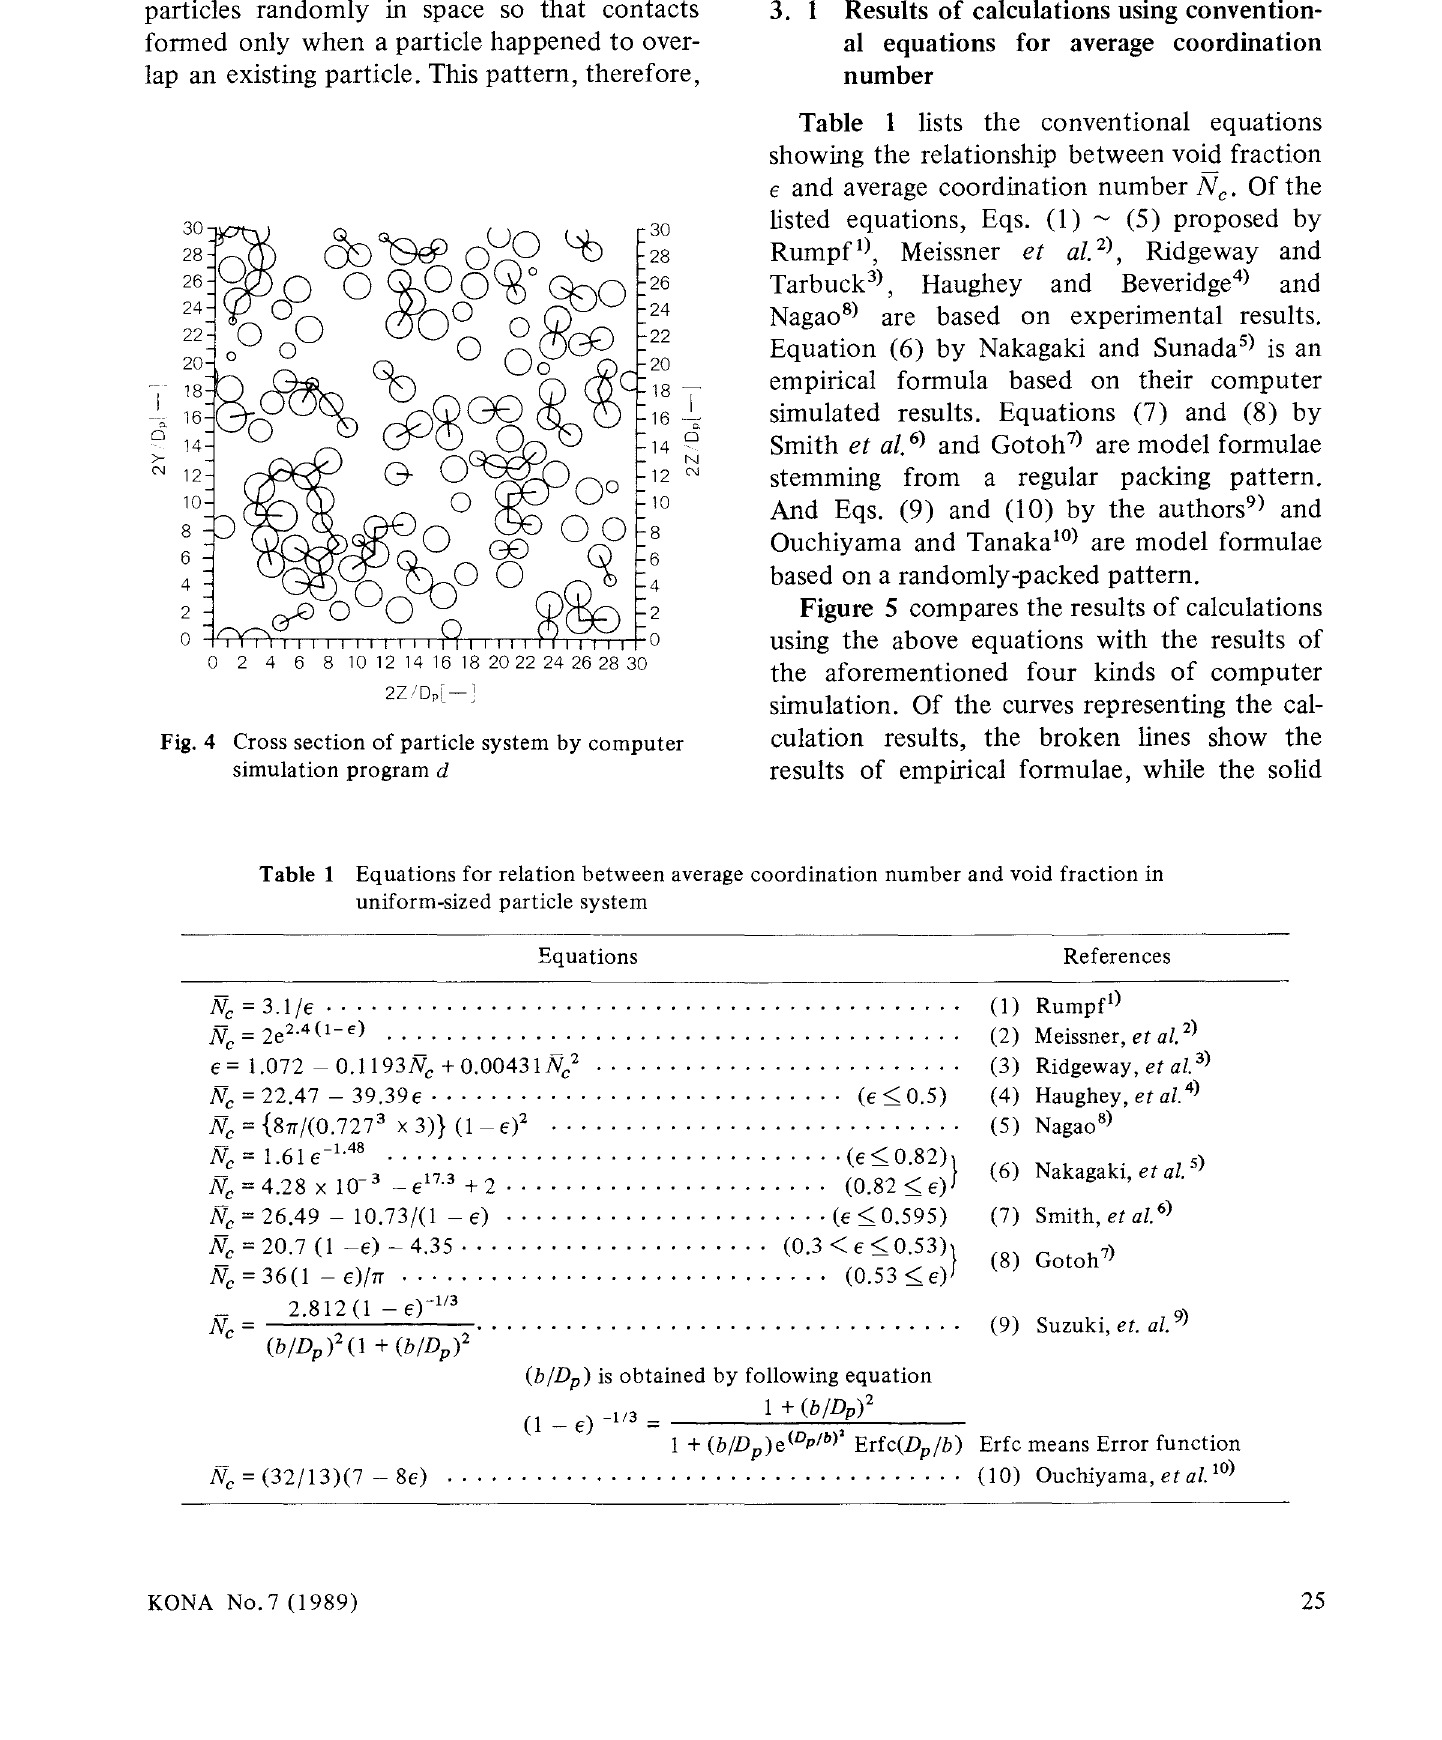
showing the relationship between void fraction E and average coordination number